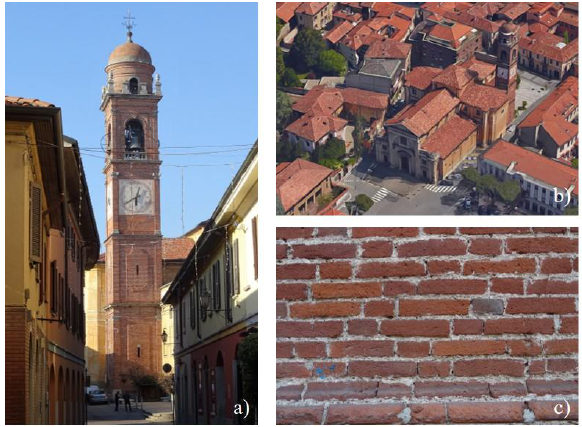
Figure 4. The Sanctuary of the Holy Virgin of the Rosary: a) the bell-tower; b) a sky view of the church and c) its masonry.